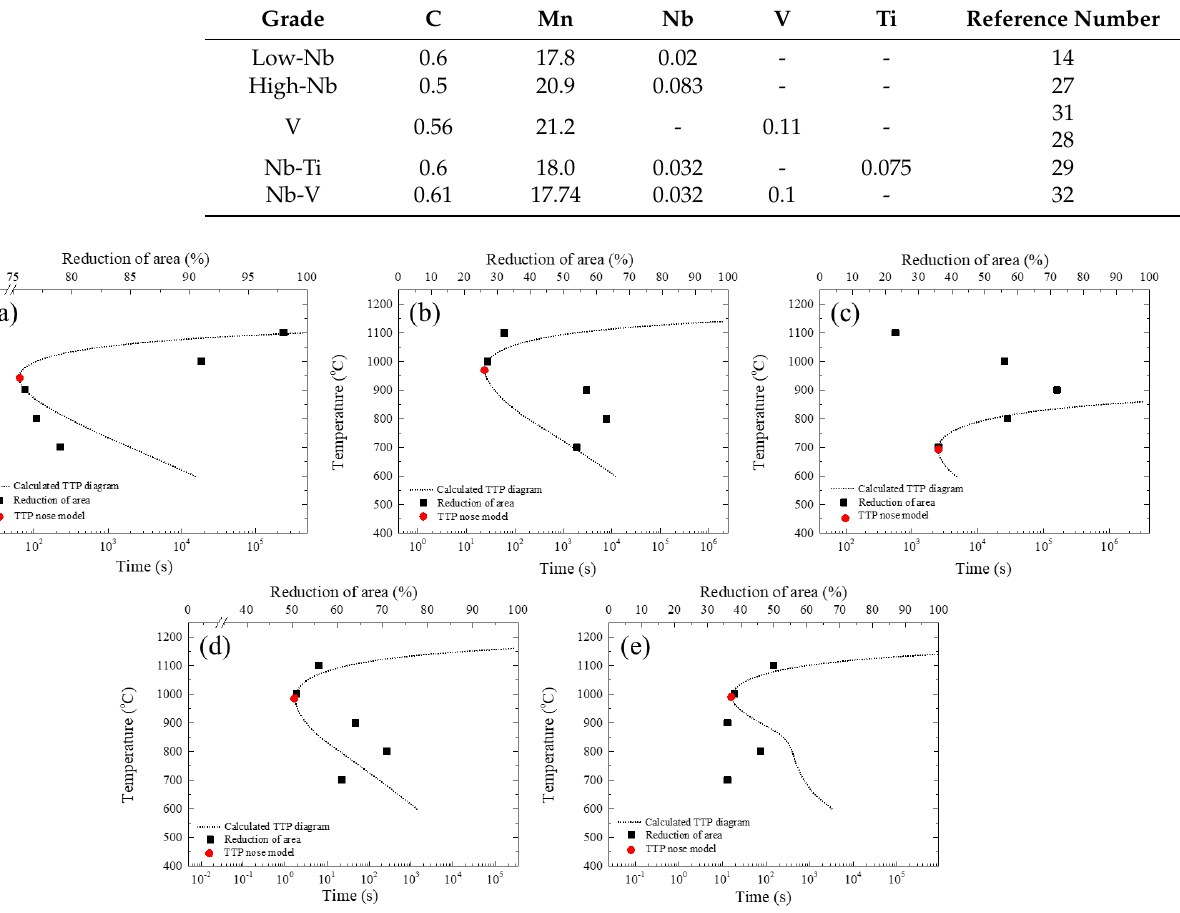
Figure 12. Comparison of model predictions and reduction-of-area results; ( a ) low Nb, ( b ) high Nb, ( c ) V, ( d ) Nb-Ti, ( e ) Nb-V; (dashed line: calculated TTP diagram from J-matpro, square point: reduction of area and red dot: TTP T N from prediction model).